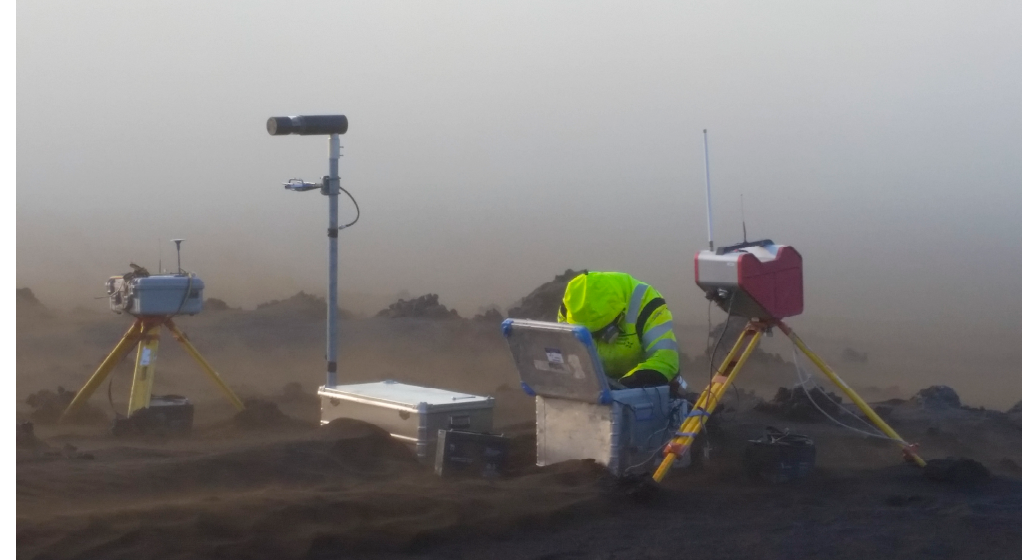
Figure 1. OPC, ScanDOAS, and NicAIR II at Þorvaldshraun, 10 km northeast of the main eruption vent. The OPC and NicAIR II were moved from this site to their final locations (Möðrudalur and Vaðalda, respectively) due to problems operating them at this site. The visibility is poor because of a dust storm, which are common here.